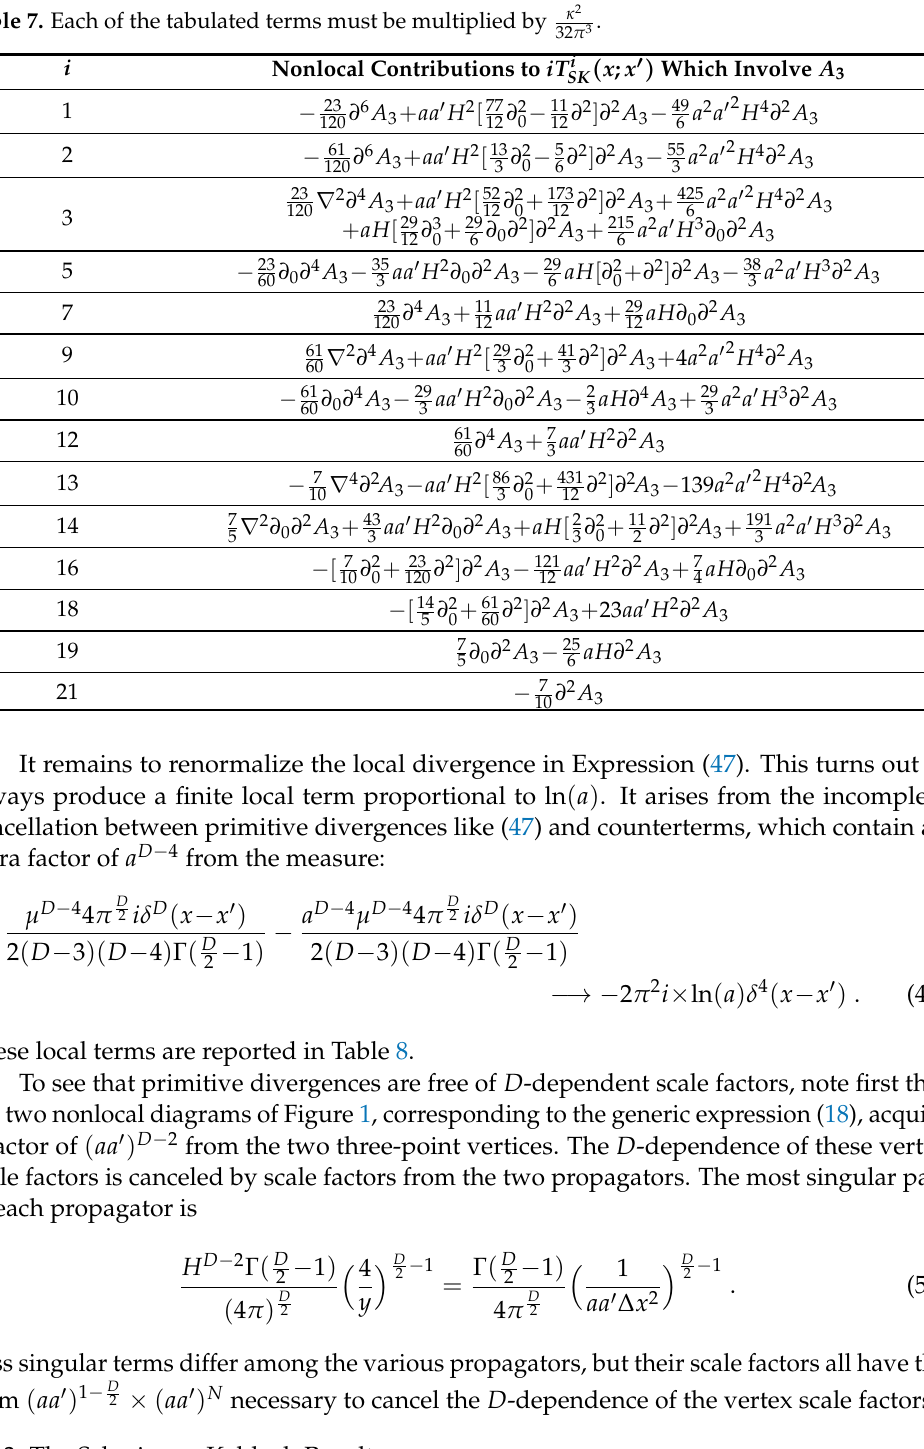
Table 7. Each of the tabulated terms must be multiplied by κ 2